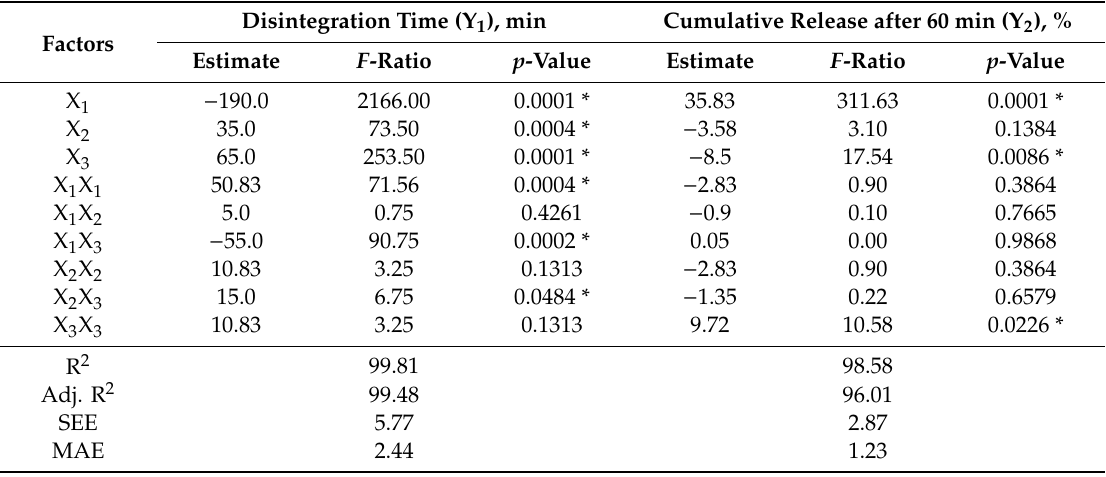
Table 4. Statistical analysis of variance (ANOVA) of the responses (Y 1 and Y 2 )